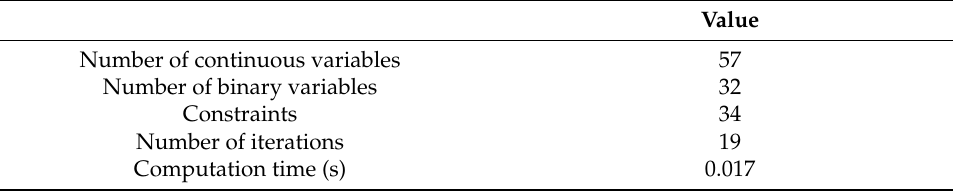
Figure 4. Schematic diagram of the proposed optimization framework. The problem sizes and the computation time of the proposed MINLP model for the LNG terminal are shown in Table 8. Table 8. Problem sizes and computation